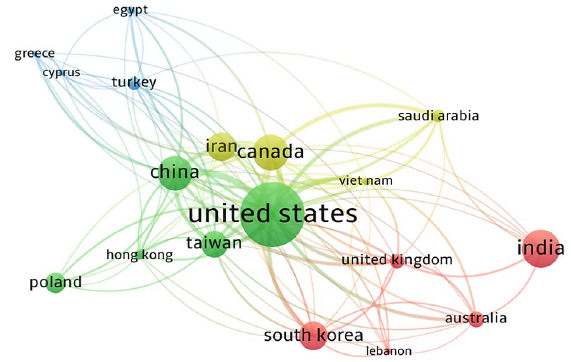
Figure 7. Science mapping of most influential